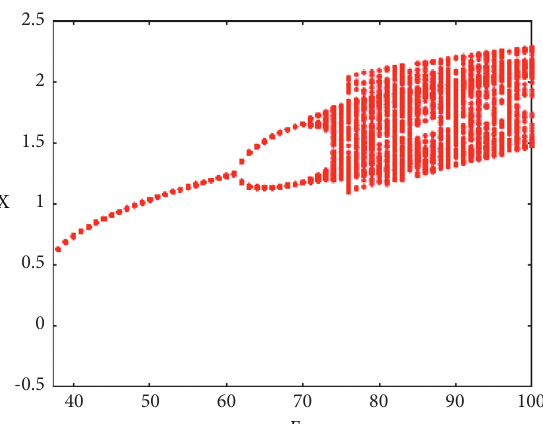
Figure 1: Local bifurcation diagram of the system at τ � 1.2 and ω � 3.9 ( c � 0.5, c